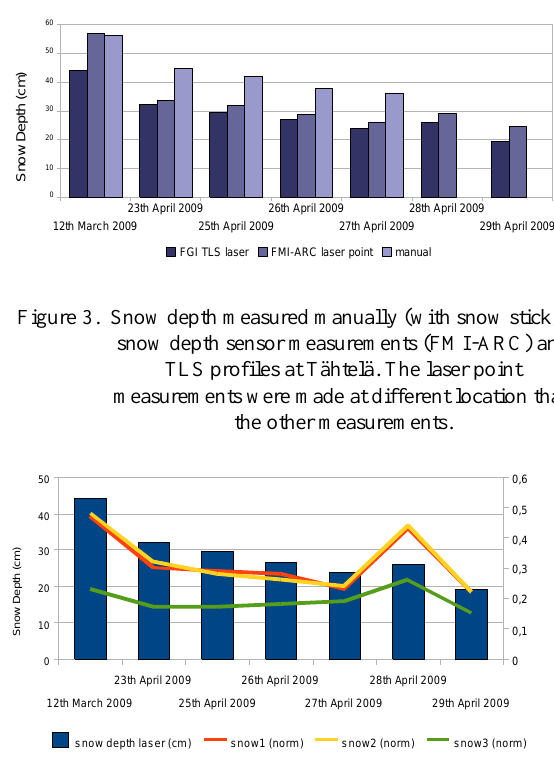
Figure 4. The calibrated TLS intensity (backscattered reflectance) and snow depth (measured with TLS) at the Tähtelä measurement site. The intensity (backscattered reflectance) scale is on the right of the plot.